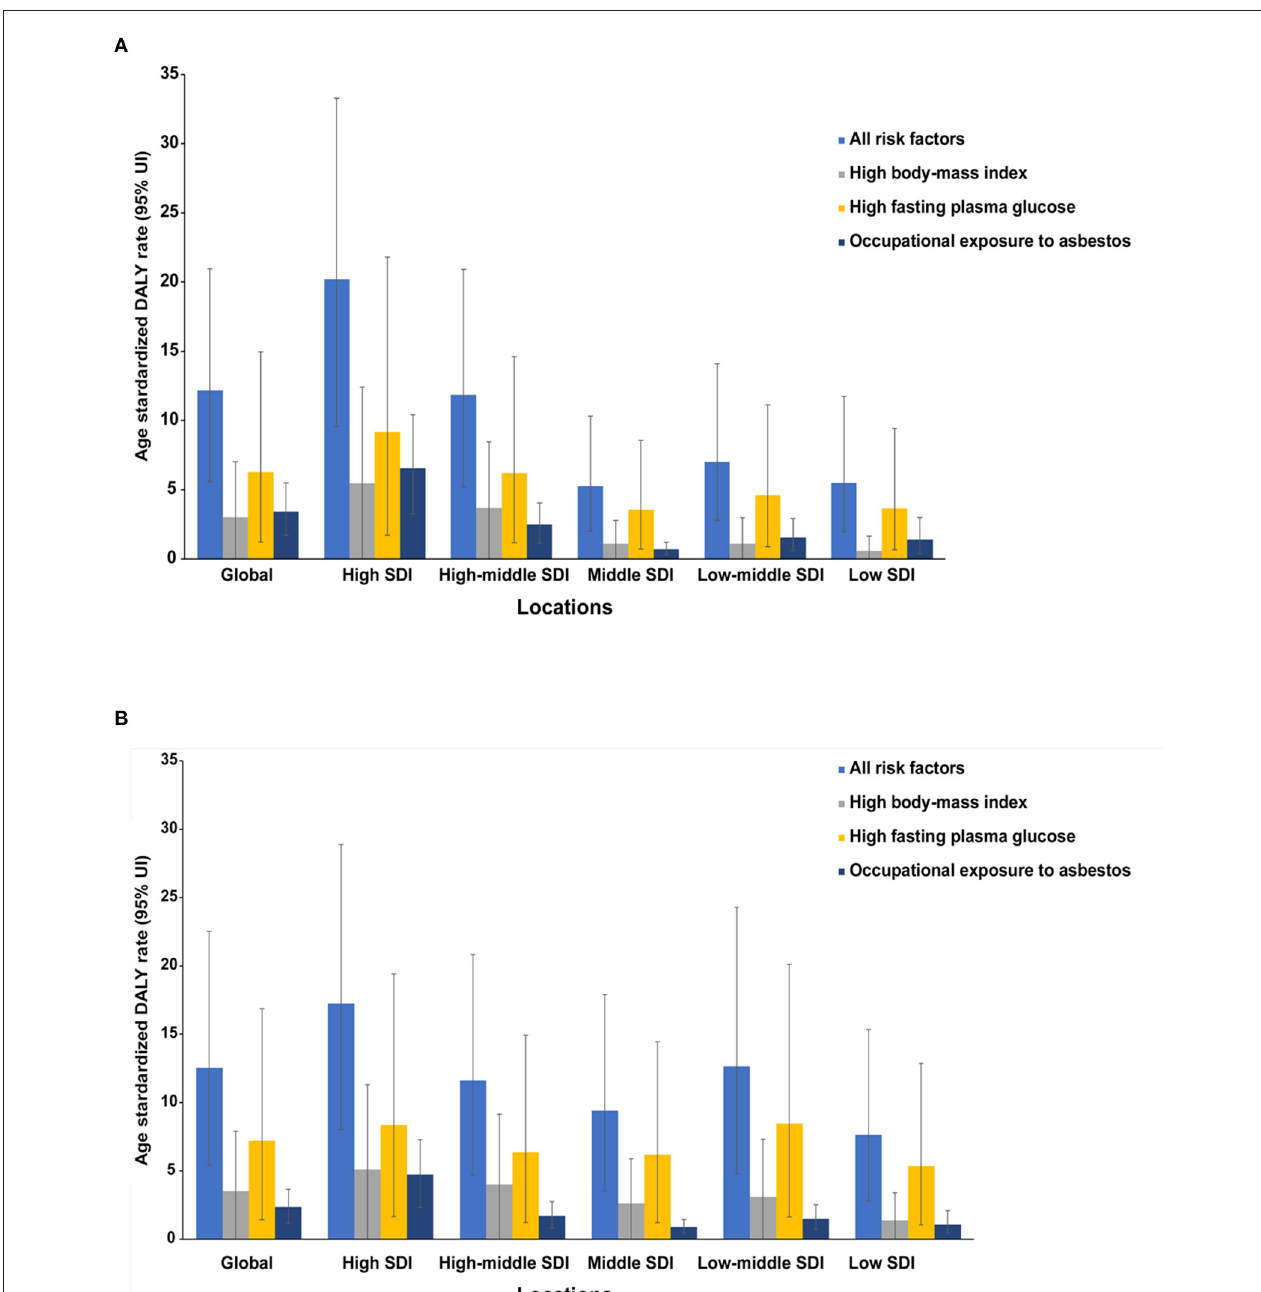
FIGURE 4 | The ovarian cancer DALYs attributable to risk factors compared in 1990 (A) and 2017 (B) by SDI quintiles. DALY, disability-adjusted life